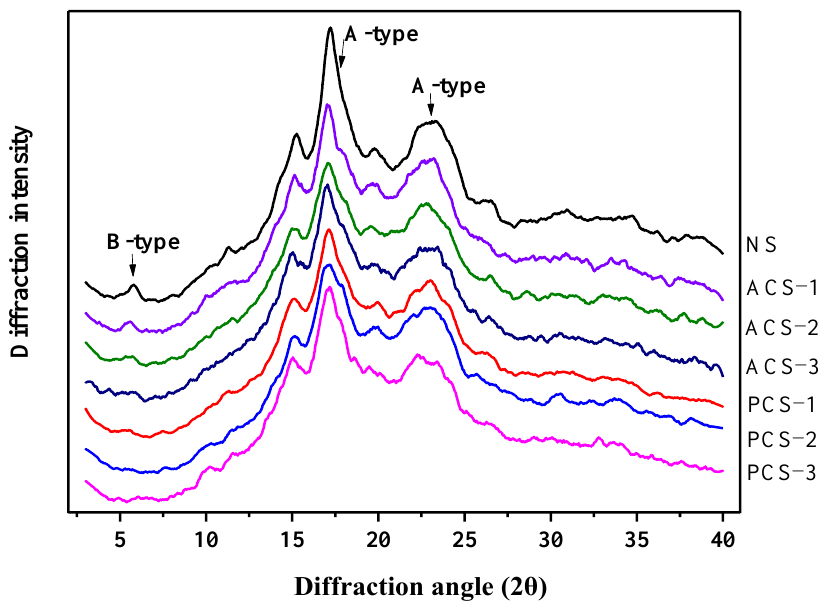
Figure 2. XRD spectra of native, phosphorylated and acetylated chestnut starch. The decrease in peak intensity after modification compared with that of native starch indicated that modification altered the relative crystallinity of chestnut starch. The relative crystallinity of starch followed the order of native starch > acetylated starch > phosphory- lated starch. The increase in the DS of the modified starch was generally accompanied by decreases in relative crystallinity. Chemical modification can reduce the hydroxyl groups that may participate in the generation of intra/inter-molecular hydrogen bonds necessary for helical crystalline structure formation in starch. In the present study, phosphoryla- tion decreased the formation of intra/inter-molecular hydrogen bonds more significantly than acetylation, making the crystalline structure of starch granules less ordered. Acetic anhydride shows a poor penetrating ability in starch granules. Acetylation occurs in all amorphous regions as well as at the outer lamellae of the crystalline regions, rather than throughout the crystalline regions of the whole starch granule. The decreasing degree of the crystalline order in starch after acetylation is dependent on the reaction time and DS as reported by Sindhu et al.